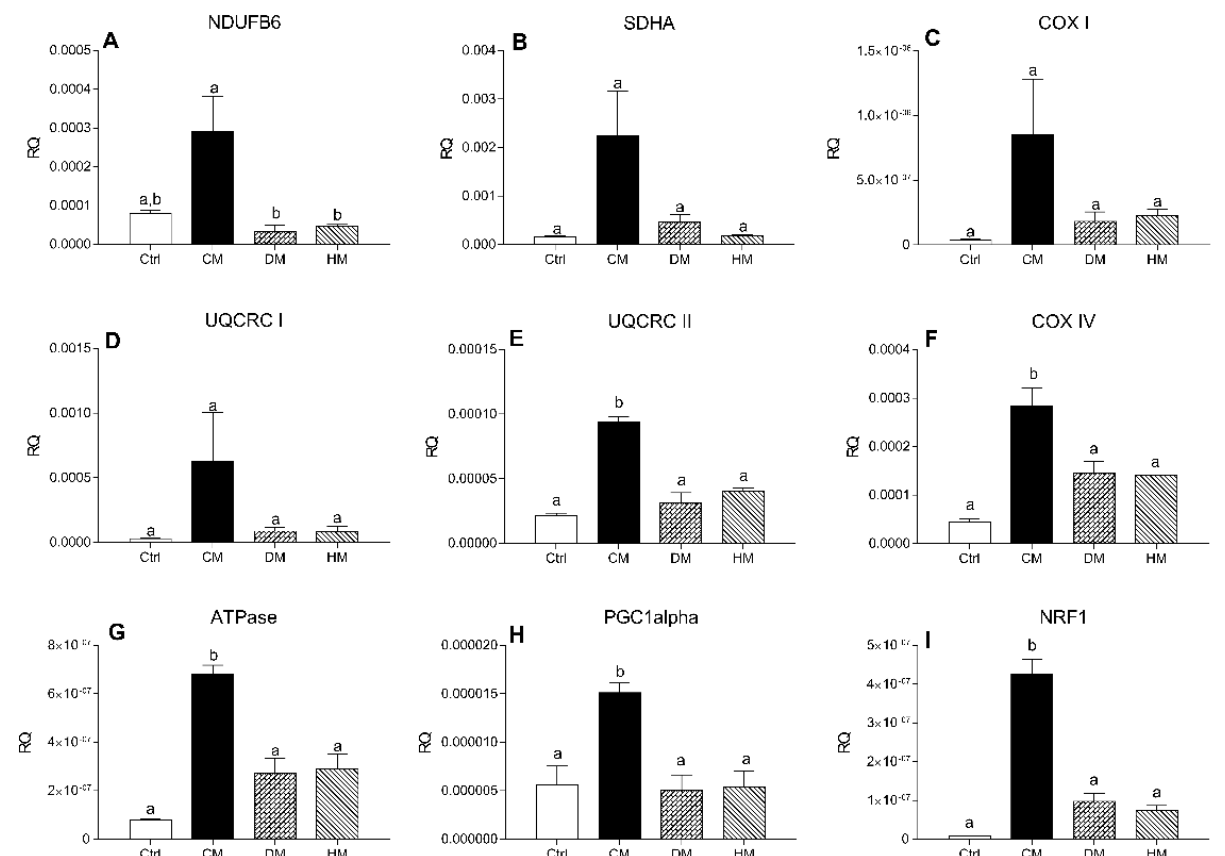
Figure 5. mRNA levels of complex I-II subunits in heart tissue. The transcription levels of NDUFB6 ( A ), SDHA ( B ), COX-I ( C ), UQCRC-I ( D ), UQCRC-II ( E ), COX-IV ( F ), ATPase ( G ), PGC-1alpha ( H ) and NRF ( I ) genes were evaluated by Real-Time PCR. Results are expressed as relative quantification (RQ) and are the mean of three independent experiments ( n = 3/group). Different letters (a,b) on top of the bars indicate statistically significant differences ( p < 0.05) among groups.